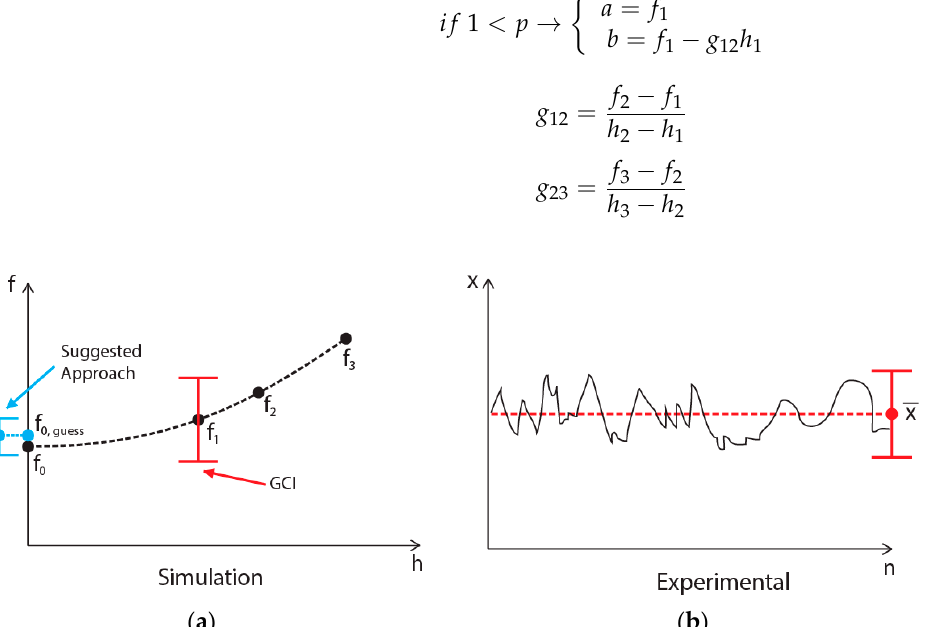
Figure 1. An illustration of how uncertainty is calculated: ( a ) within computational fluid dynamics (CFD); ( b ) within an experiment.